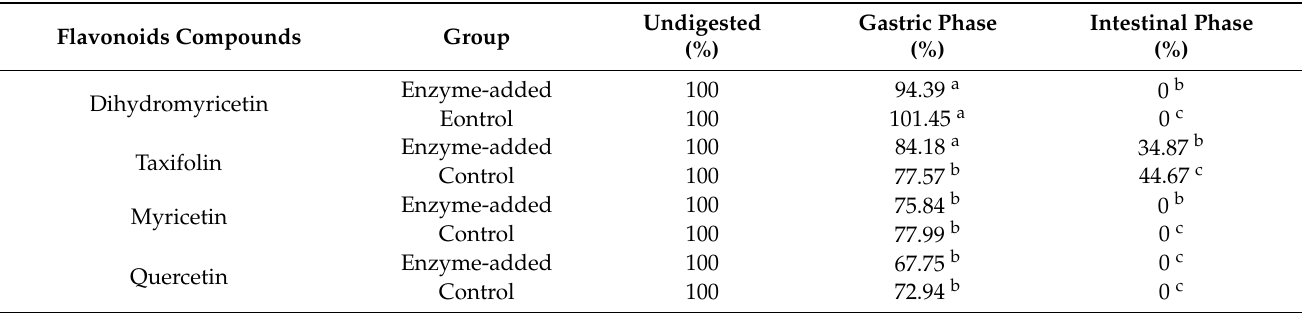
Table 7. Content of individual flavonoids compounds in Semen Hoveniae extracts before and during the simulated